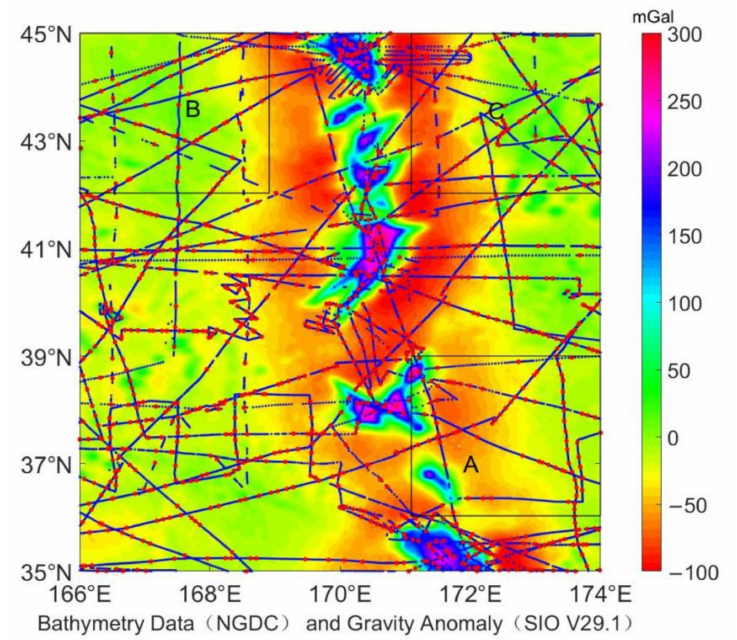
Figure 1. Bathymetry data: control points in cyan and check points in red; gravity anomaly: it comes from SIO